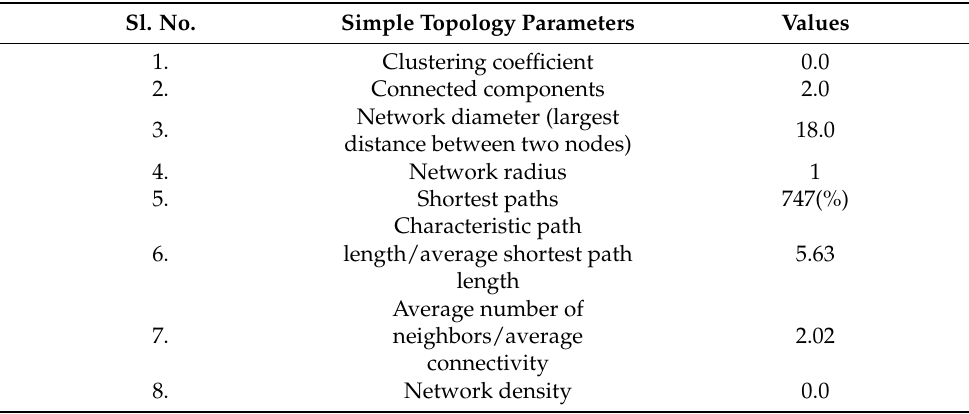
Table 1. Simple topology parameters of fruiting network. Sl.